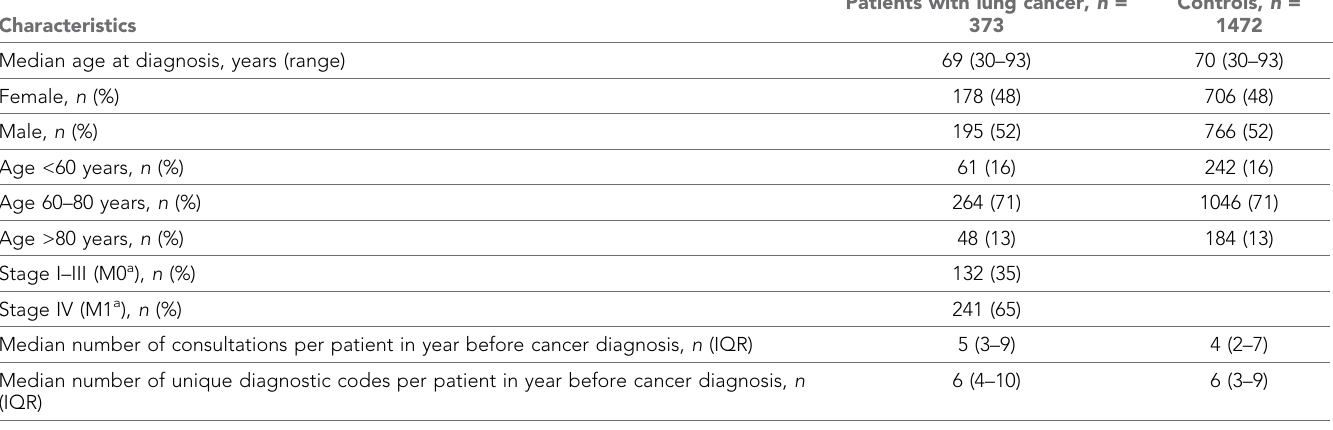
Table 1. Sample characteristics of patients with lung cancer and controls